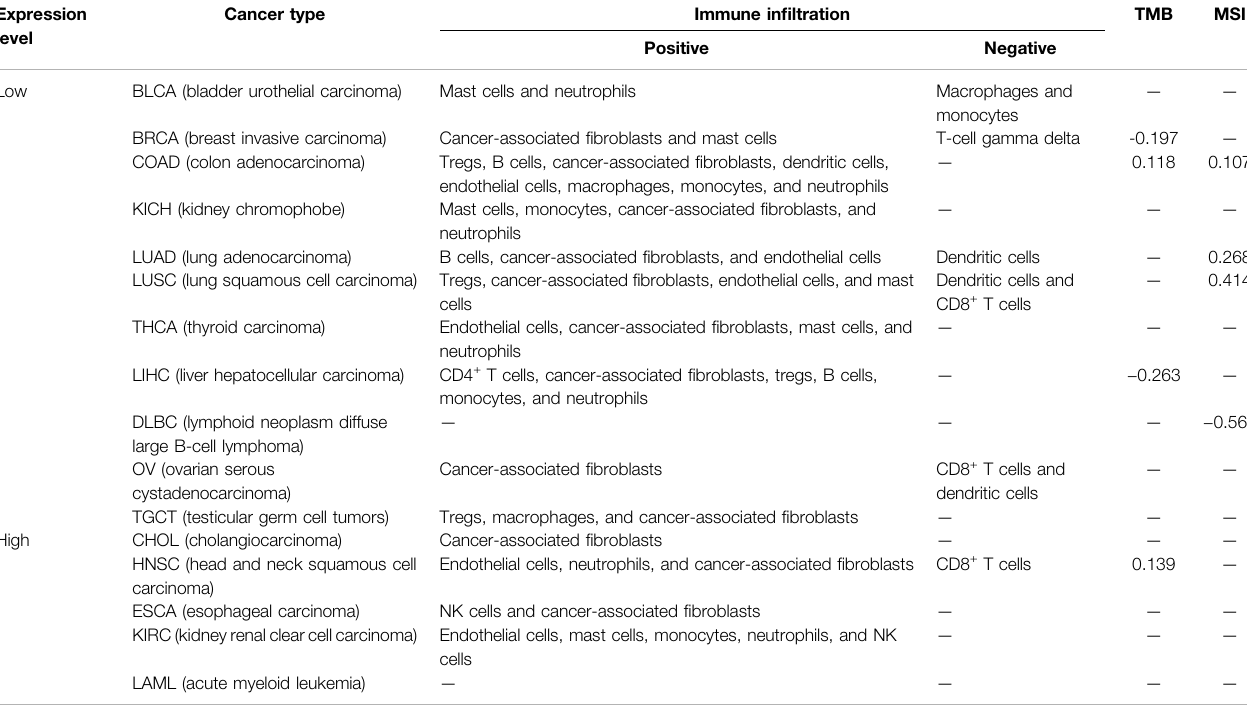
TABLE 2 | KDM6B expression level and the correlation with immune in fi ltration, TMB, and MSI in various cancers, in which the KDM6B expression level was signi fi cantly different from its matched normal tissues. p < 0.05 was considered signi fi cant, and only the signi fi cant correlation was exhibited in the table. Expression